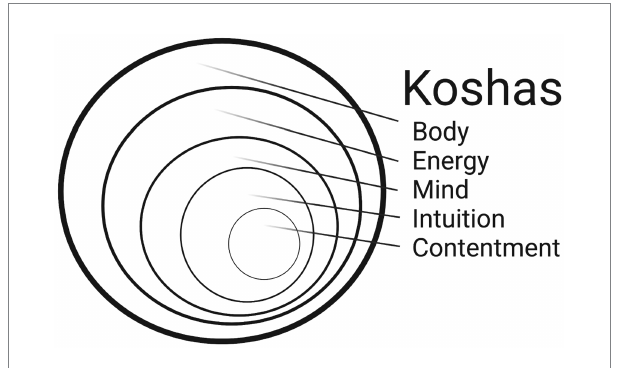
FIGURE 1 Diagram demonstrating the concentric nature of the